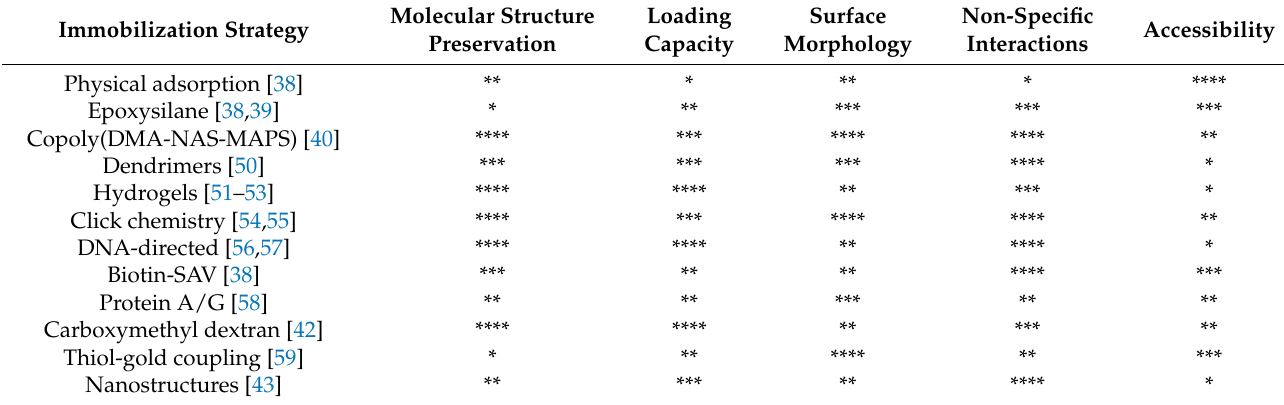
Table 2. Features of the surface chemistry methods discussed here, ranked from * to ****, where a higher number of asterisks indicates a better